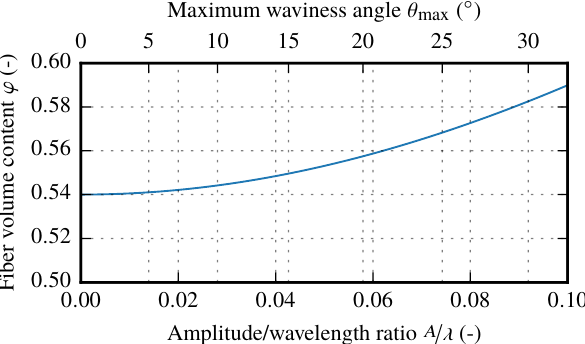
Figure 18. Effect of the amplitude to wavelength ratio A / λ or the corresponding maximal fiber deviation angle θ max on the resulting fiber volume